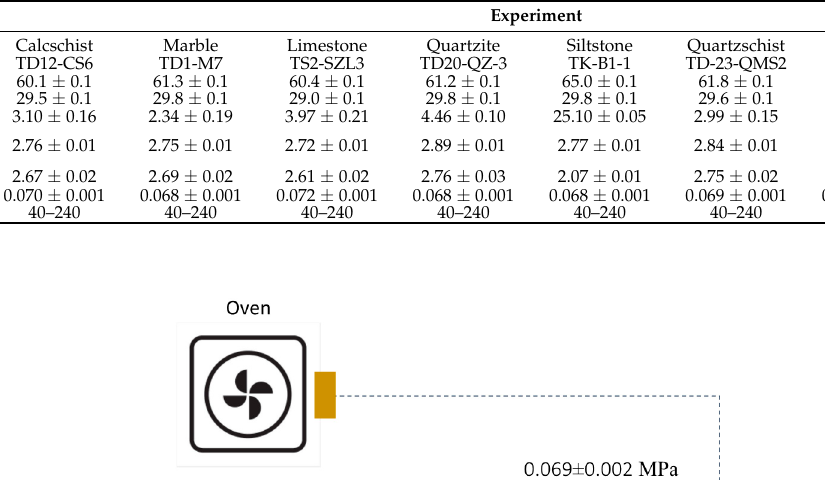
Table 6. Properties of the core samples used for studying the effect of temperature on seismic velocity. Temp. Effect